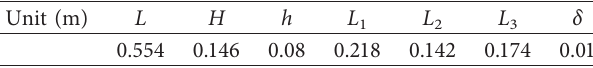
(iii) The fluid air (Pr � 0.7) is a constant physical � 300 K T int